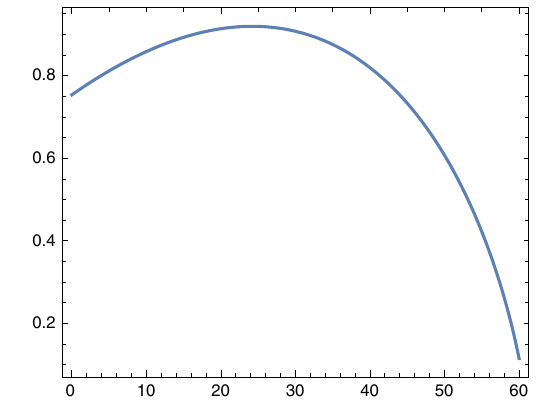
(χ) ∼ χ 3 and with (cid:13)